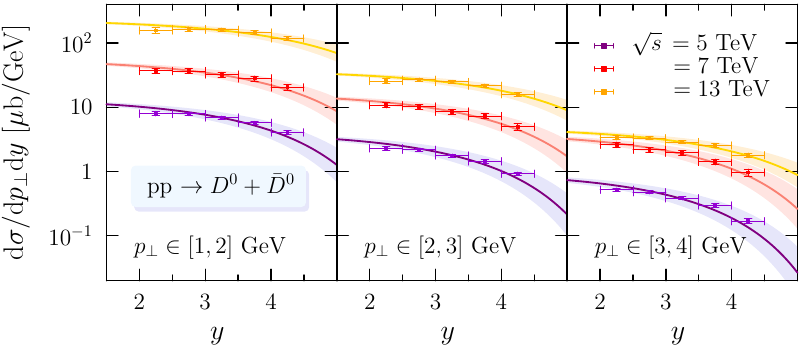
Figure 5 . Differential pp cross section for D 0 production as a function of rapidity, at the collision √ energies s = { 5 , 7 , 13 } TeV. The panels depict (B.1) evaluated at the central values of three experimental p -bins, namely, p = 1 . 5 GeV (left), 2 . 5 GeV (central) and 3 . 5 GeV (right). (For the ⊥ ⊥ 13 TeV data, two bins were combined.) The bands correspond to the variation of the parameter √ n = 4 ± 1 in (B.1). The curves (and data points) at different s were multiplied by 4 − k (with √ k = 0 , 1 , 2 for decreasing s